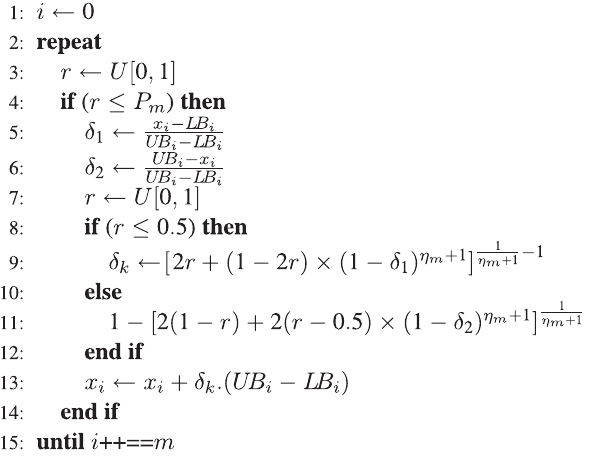
Figure 1: Highly Disruptive Polynomial